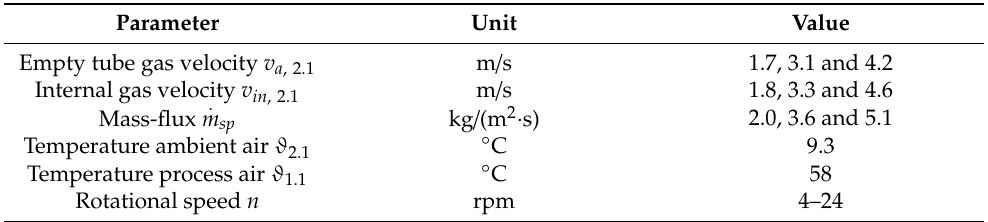
Table 7. Operating conditions for temperature e ff ectiveness dependence to empty tube gas velocity and rotational